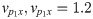
Perturbation of key CTBG loop gains during DBS with νζx = −1.2 mVs, vp1x,vp1x=1.2 mVs, and all other parameters as defined in Table 1.(a) Dependence of loop gains on the DBS pulse frequency. (b) Dependence of loop gains on the DBS pulse frequency.